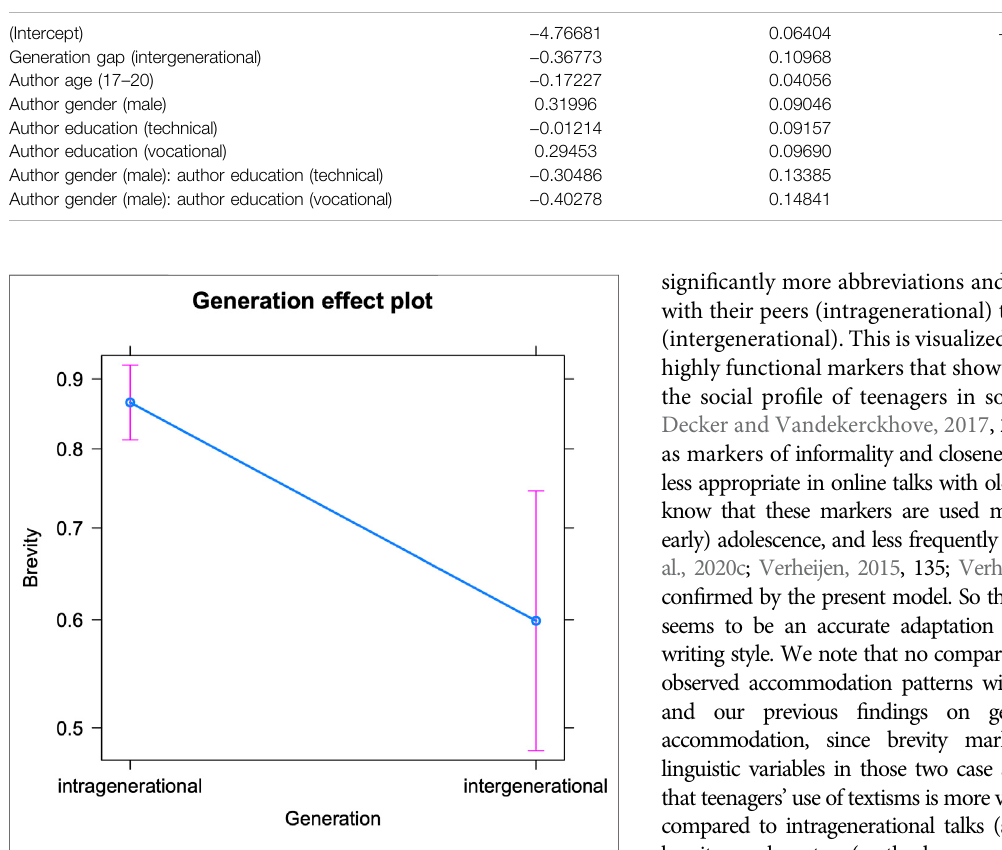
FIGURE5| Brevity markersin intra-vs. intergenerational talks(predicted counts per 100 tokens).